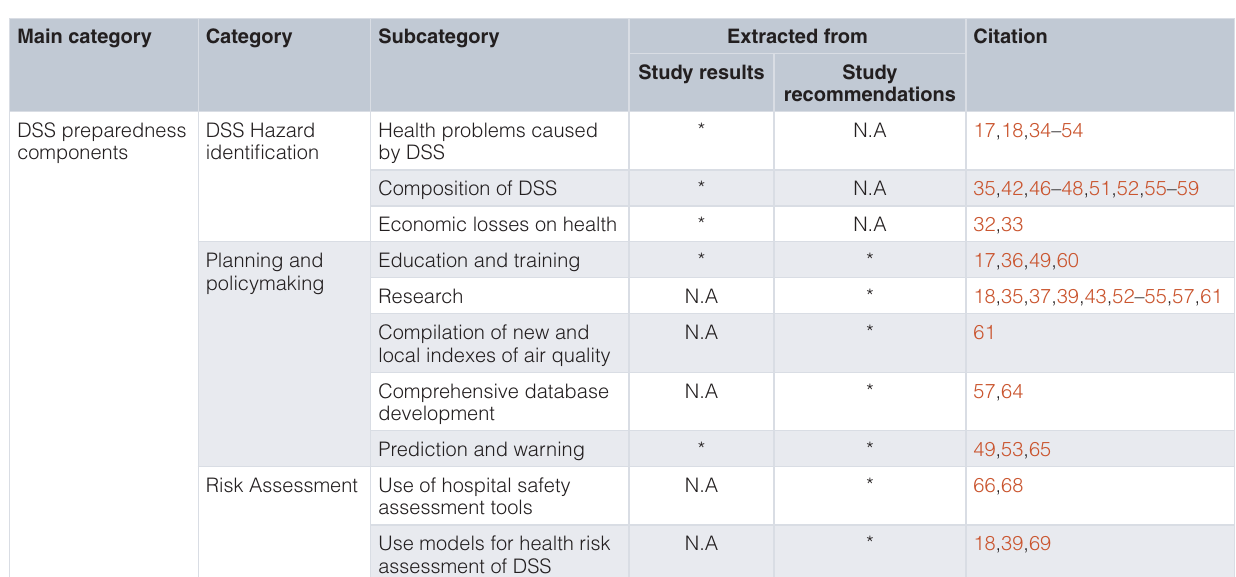
Table 3. Preparedness components of health systems for DSS in